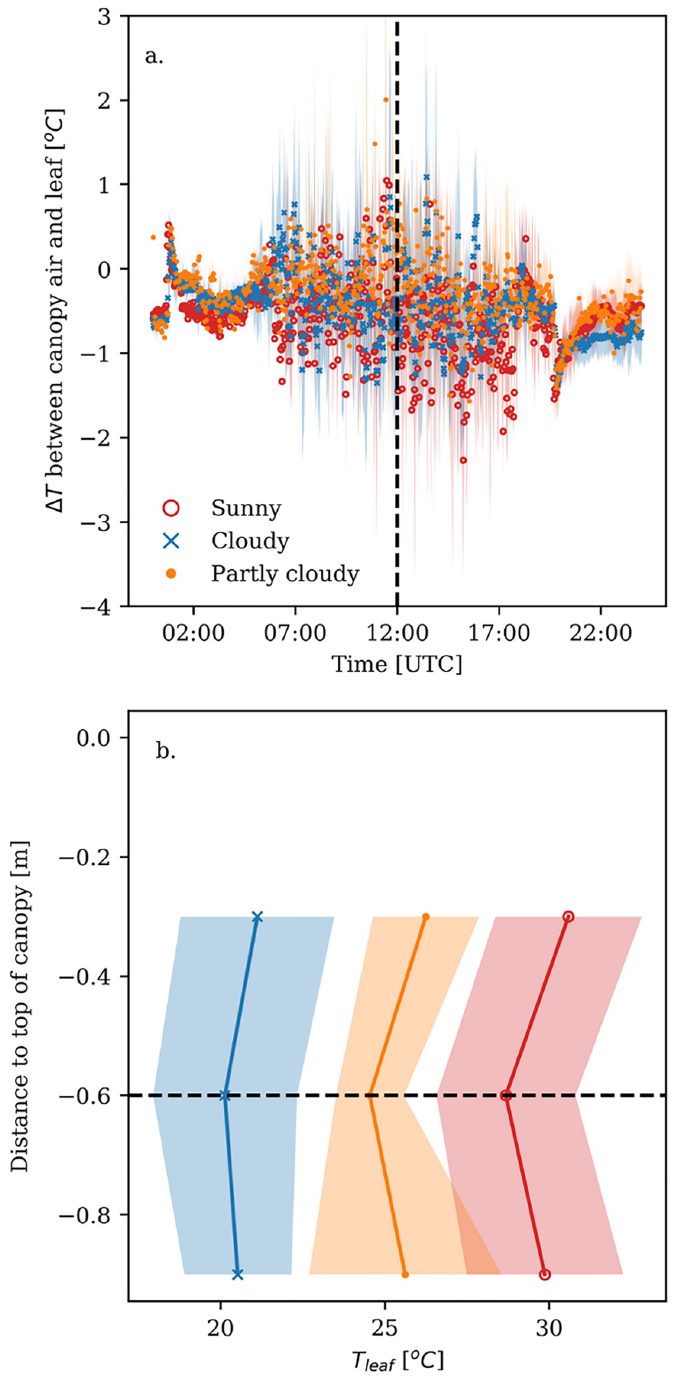
Fig 7. Difference between canopy air and leaf temperature both 60cm below the top of the canopy. Bold lines represent the average value, whereas the shaded area represents the standard deviation over the days for sunny (red), cloudy (blue) and partly cloudy days (orange). a.) time course of the temperature difference, where the dashed line indicates noon. b.) vertical leaf temperature profile at noon; the dashed line shows the height at which the difference between canopy air and leaf temperature was